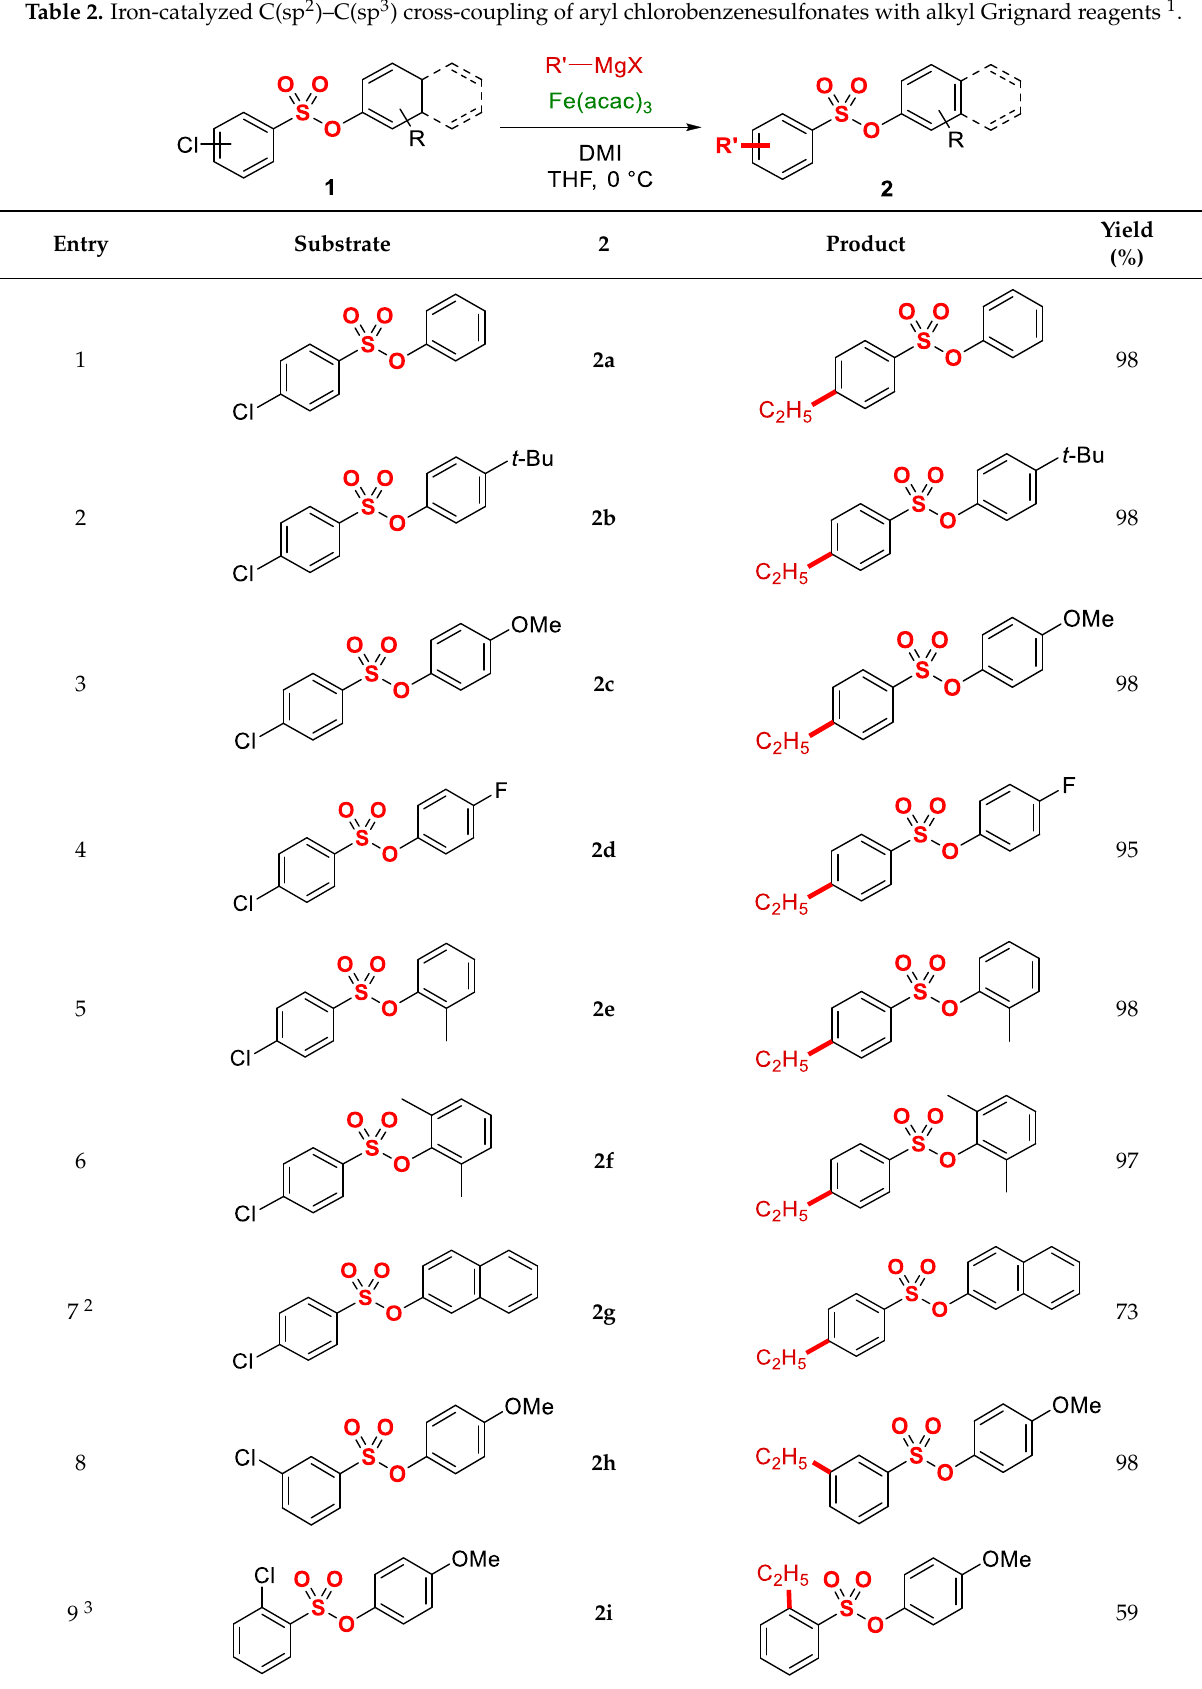
Molecules 2021 , 26 , x FOR PEER REVIEW